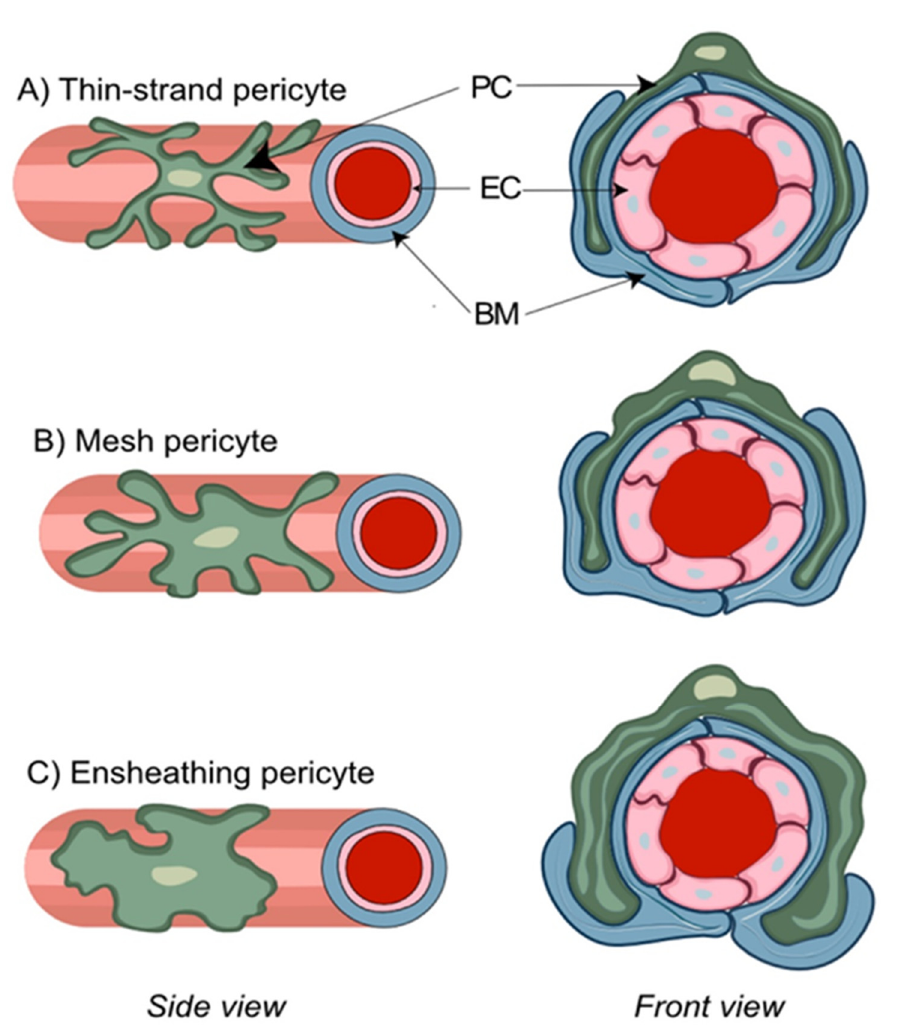
Figure 2. Morphological features of distinct pericyte (PC) subtypes. PC are characterized by a typical “bump on a log” appearance arising from an ovoid protruding nucleus and extending cytoplasmic processes that contact the abluminal side of the vascular basal membrane (BM) and run inside of its duplicature. Thin-strand pericytes ( A ) possess relatively long thin cytoplasmic processes with a complex branching pattern that sparsely cover brain capillaries. Mesh pericytes ( B ) have a less complex branching pattern, and their thicker and shorter processes provide more comprehensive coverage of brain capillaries. Ensheathing pericytes ( C ) are characterized by the least complex branching pattern and almost complete coverage of pre-capillary arterioles.